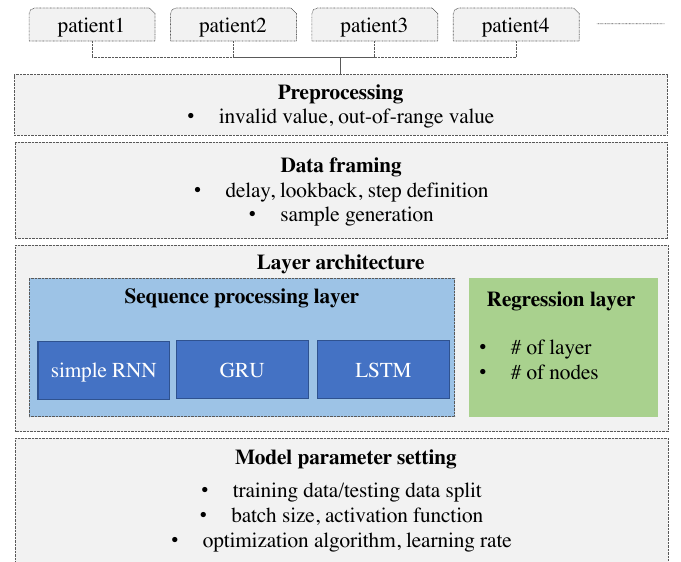
Figure 1. Research